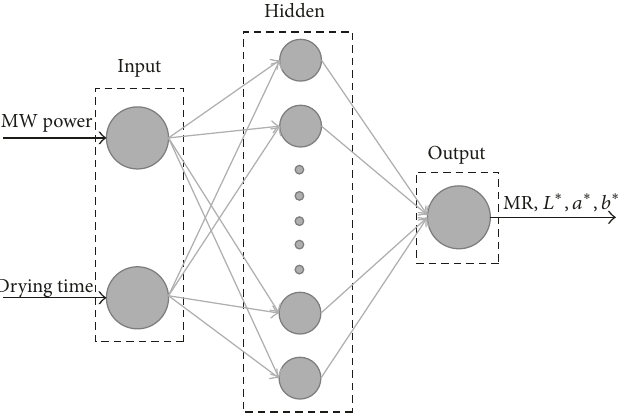
Figure 1: Artificial neural network